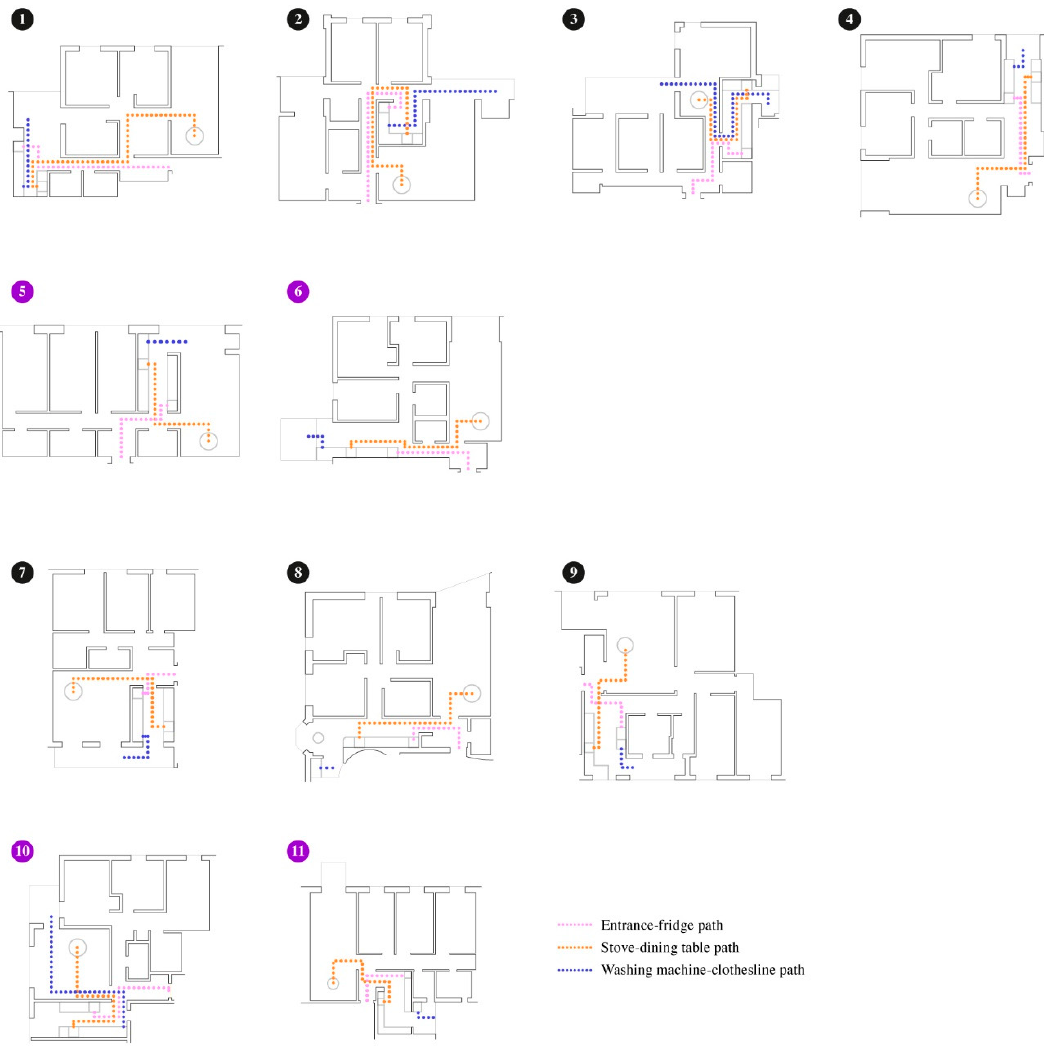
Table 3. Kitchen lighting and views.